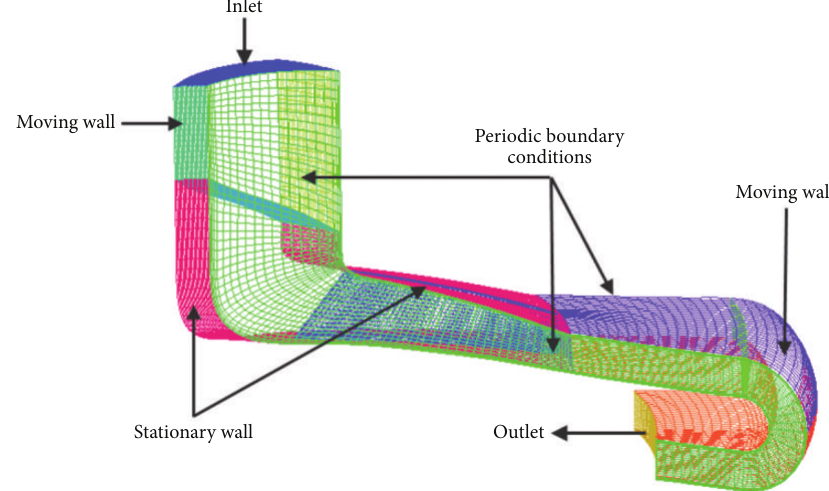
Figure 4: Boundary conditions.